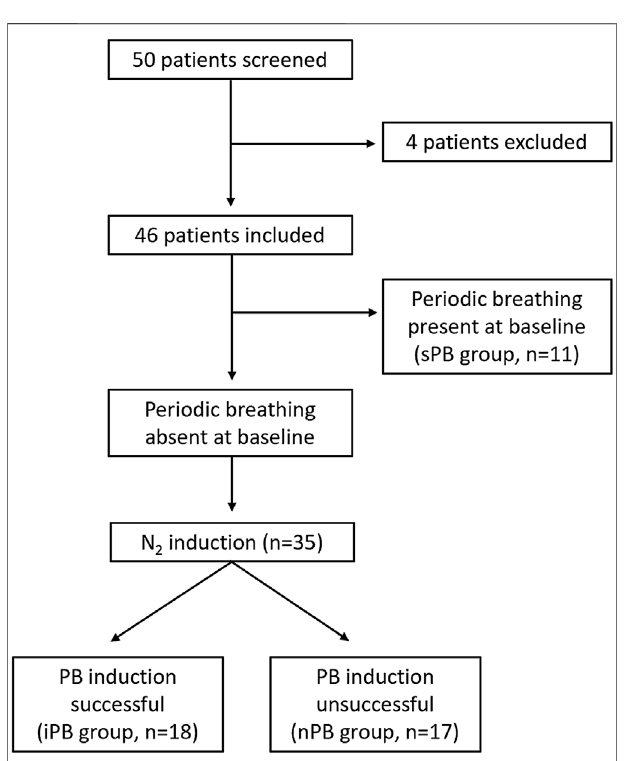
FIGURE5| Study fl owchart.Graphicalpresentationofthedistributionof patients enrolled into the study.